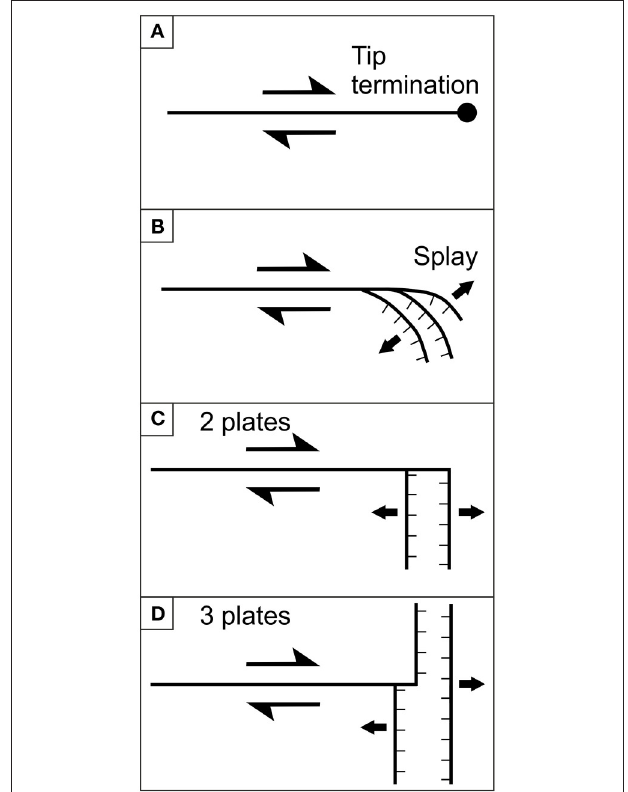
FIGURE 1 | Schematic diagram illustrating the four basic types of strike-slip fault terminations. (A) The strike-slip fault ends at a tip surrounded by undeformed rocks; (B) the strike-slip fault terminates with a splay, which in this example creates a transtensional zone; (C) the strike-slip fault terminates in correspondence of a normal or reverse fault; (D) the strike-slip fault terminates against another through-going fault system. ( A , C , and D modified after Mouslopoulou et al.,